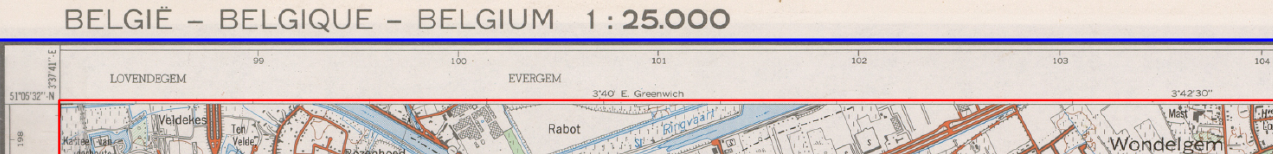
Figure 2. Outer rectangle detected by morphological operations (in blue), and the effective map region determined via text recognition at the surrounding coordinates (in